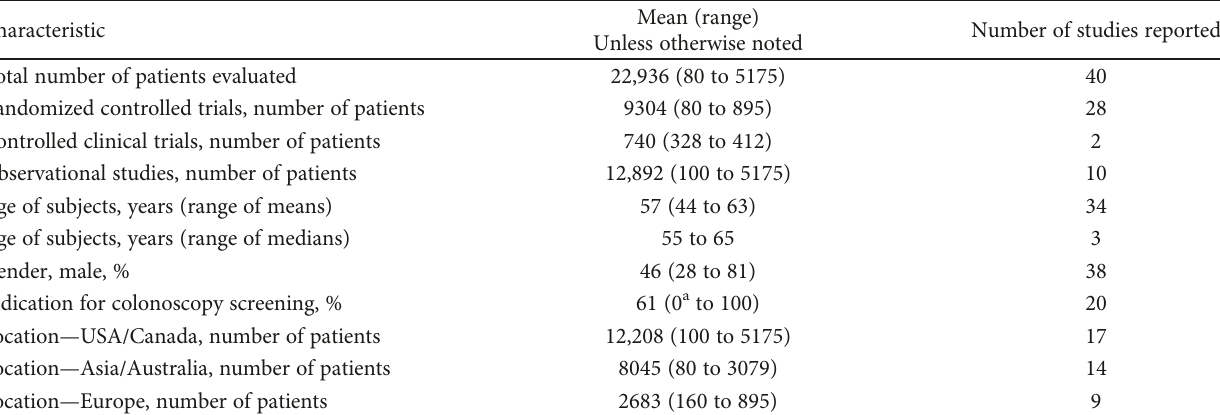
Figure 1: Literature fl ow chart. Table 1: Summary of baseline